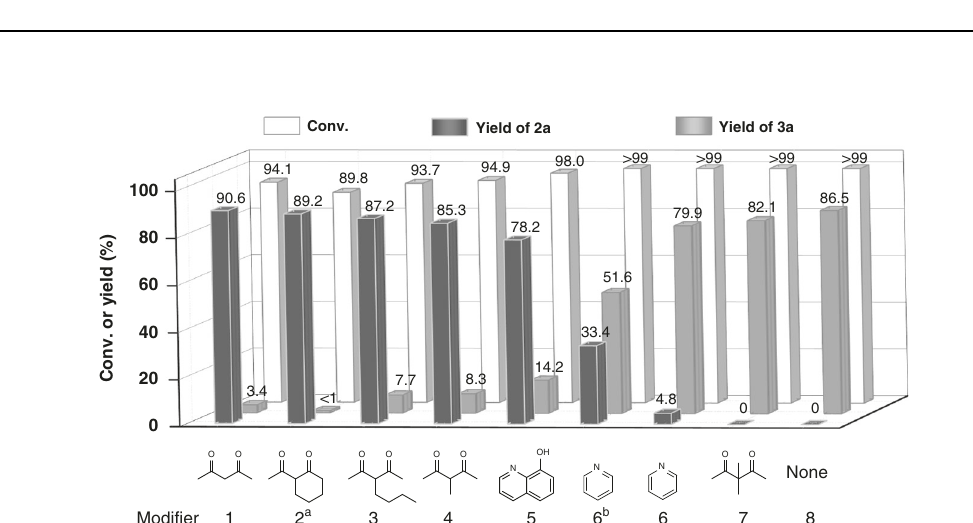
Fig. 1 Performance of MnO x with different modi fi ers in the aerobic oxidation of benzylamine. Reaction conditions: 1 mmol benzylamine, 0.1 mmol MnO x , additive/MnO x = 20 mol%, 5 mL CH 3 CN, 0.3 MPa O 2 , 90 °C, 14 h. a 20 h. b Additive/MnO x = 200 mol%